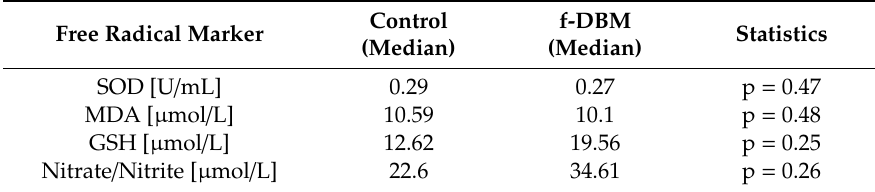
Table 4. Load of free radicals. At the age of two months, no significant di ff erences were observed between the groups. SOD = superoxide dismutase, MDA = malondialdehyde, GSH =